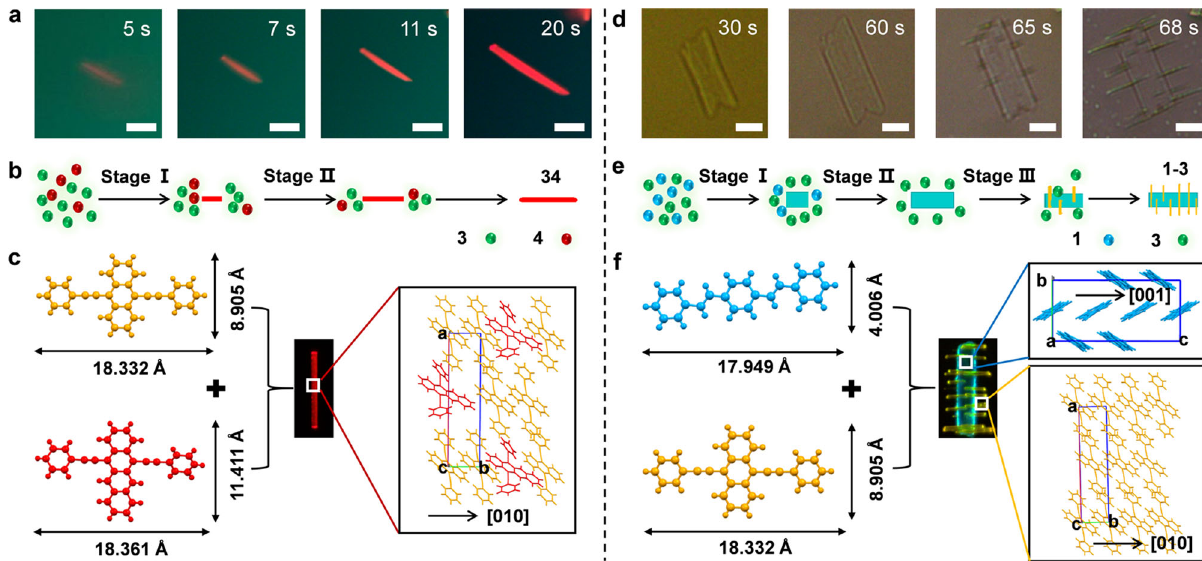
Fig. 2 The mixing behavior of binary material combinations involving 3/4 and 1/3. a , d The detailed growth processes of single binary microparticles involving a 34 ( x 4 = 5%) ribbon and d 1 – 3 branched heterostructure at different intervals ( a , t = 5, 7, 11, and 20 s; d , t = 30, 60, 65, and 68 s). Scale bars, 10 µ m. b , e Schematic showing the mixing behavior of ( b ) 34 ribbons and ( e ) 1 – 3 branched heterostructures. c , f The molecular packing motifs of single c 34 ribbon along [010] direction and f each domain in 1 – 3 branched heterostructure along [010] direction.